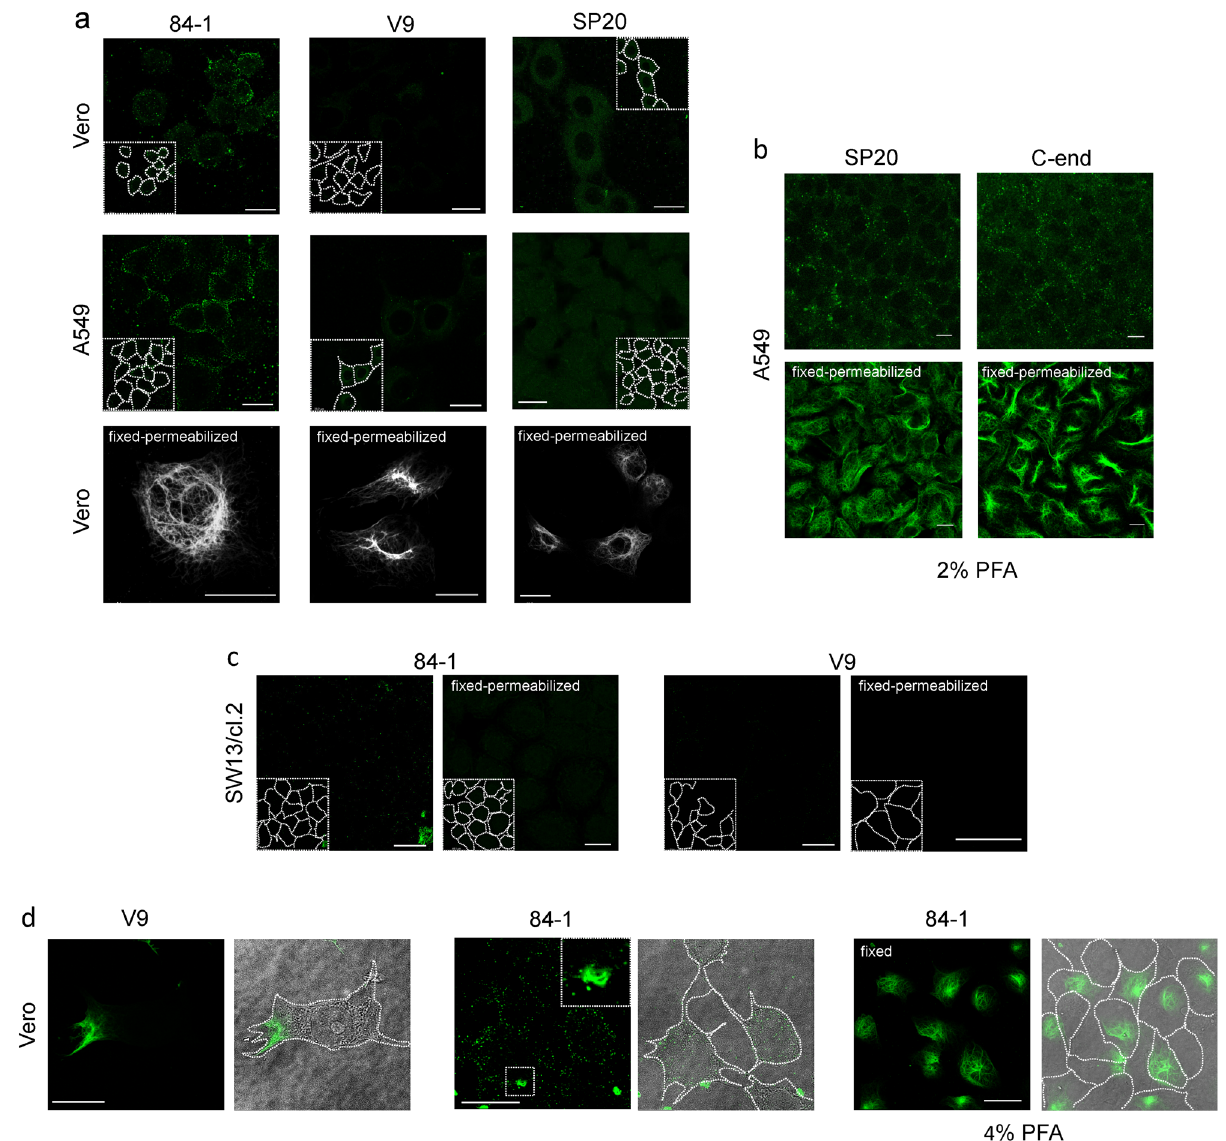
Figure 3. Detection of vimentin in several cell types by several fixation and permeabilization protocols. When indicated, cells were fixed, or fixed and permeabilized, prior to immunodetection. ( a ) In the two upper rows, Vero or A549 cells were incubated with the indicated monoclonal primary antibodies at 1:200 dilution for 1 h in the cold, followed by incubation with Alexa-488-conjugated secondary antibodies at 1:200. At the end of the procedure cells were fixed with 4% (w/v) PFA in the cold. Representative images at mid-cell height are shown. In the lower row, Vero cells were fixed and permeabilized prior to detection of cytoplasmic vimentin with the same monoclonal antibodies. ( b ) A549 cells were incubated with the indicated anti-vimentin antibodies, and the corresponding secondary antibodies, before fixation (upper panels) or after fixation with 2% (w/v) PFA and permeabilization (lower panels) for detection of cytoplasmic vimentin. ( c ) Vimentin-deficient SW13/cl.2 cells, were incubated with the indicated anti-vimentin monoclonal antibodies and Alexa-488-conjugated anti-mouse immunoglobulins at 1:200, before fixation (left images) or after fixation and permeabilization (right images). ( d ) Vero cells were incubated with the indicated anti-vimentin antibodies as described above for detection of cell surface vimentin. Images shown illustrate representative cases of cells in which an area of the cytoplasm shows staining of filamentous vimentin (left panels), or that display fragments of vimentin filaments associated to their surface (middle panels). In the right panels, Vero cells were stained with anti-vimentin antibodies after fixation with 4% (w/v) PFA in the cold without performing any additional permeabilization step. In each case, images on the right show the overlay of the bright field and fluorescence images with the contours of the cells highlighted. Insets in ( a , c ) display the approximate cell contours drawn from bright field or overexposed images, whereas the inset in ( d ) middle panels shows a cell surface-associated vimentin bundle. Bars, 20 μm in ( a , c , d ) and 10 μm in ( b